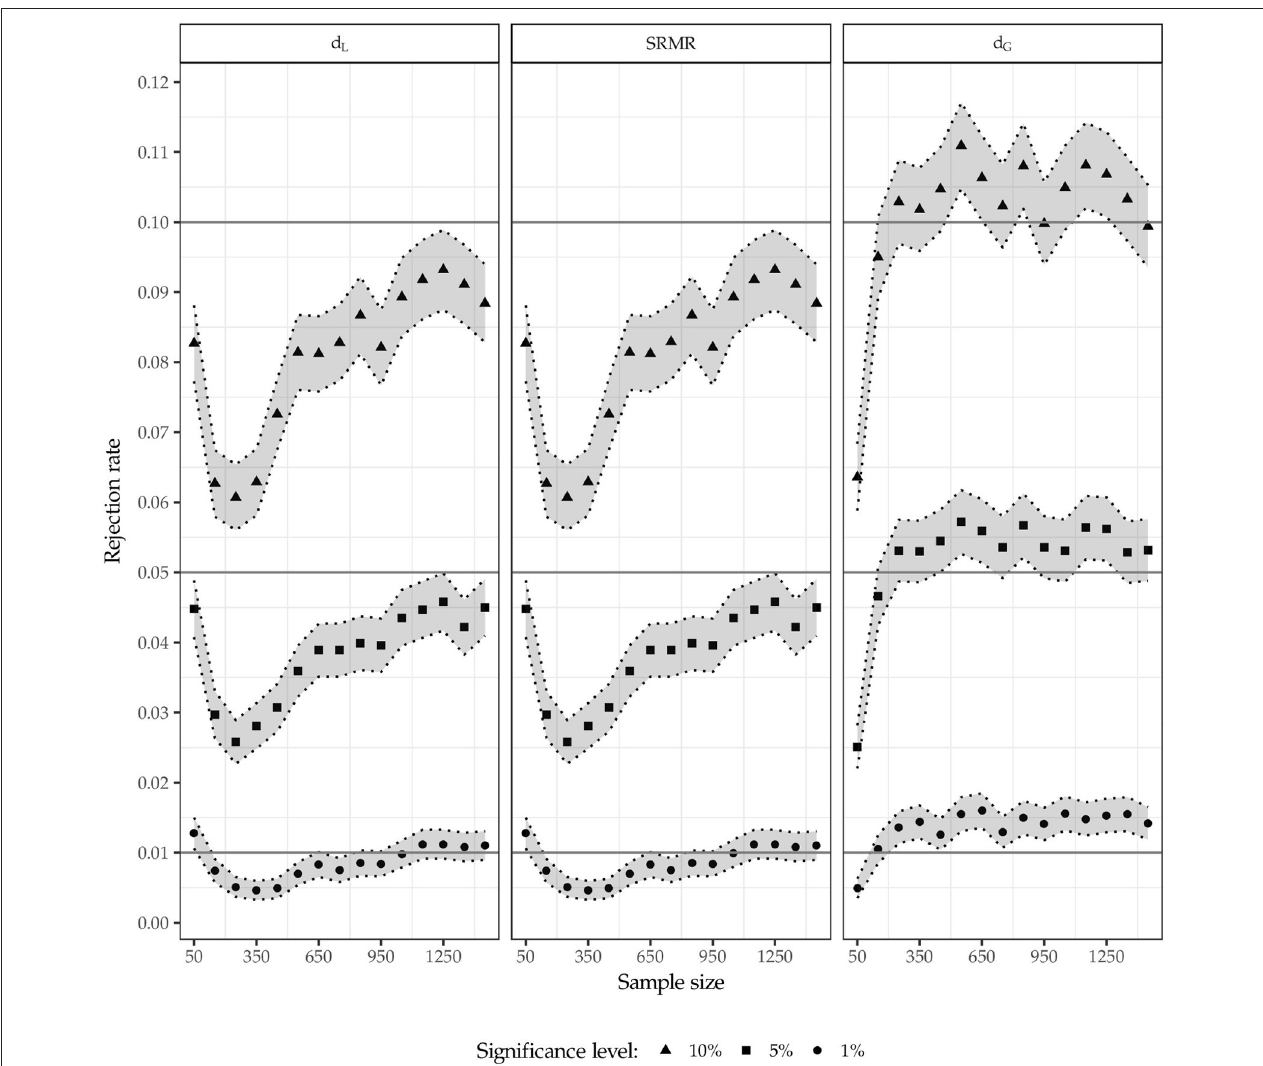
FIGURE 6 | Rejection rates for population model